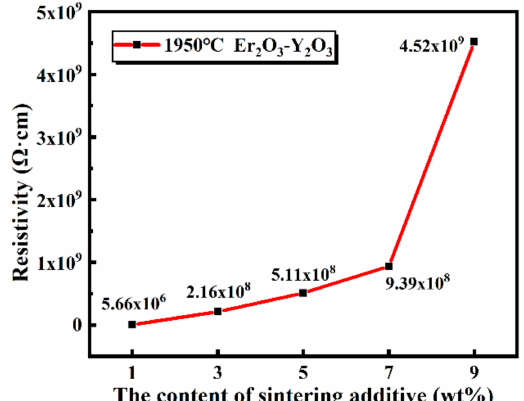
Figure 10. The dc electrical resistivity of the sintered SiC samples at 1950 ◦ C as a function of the sintering additive contents.